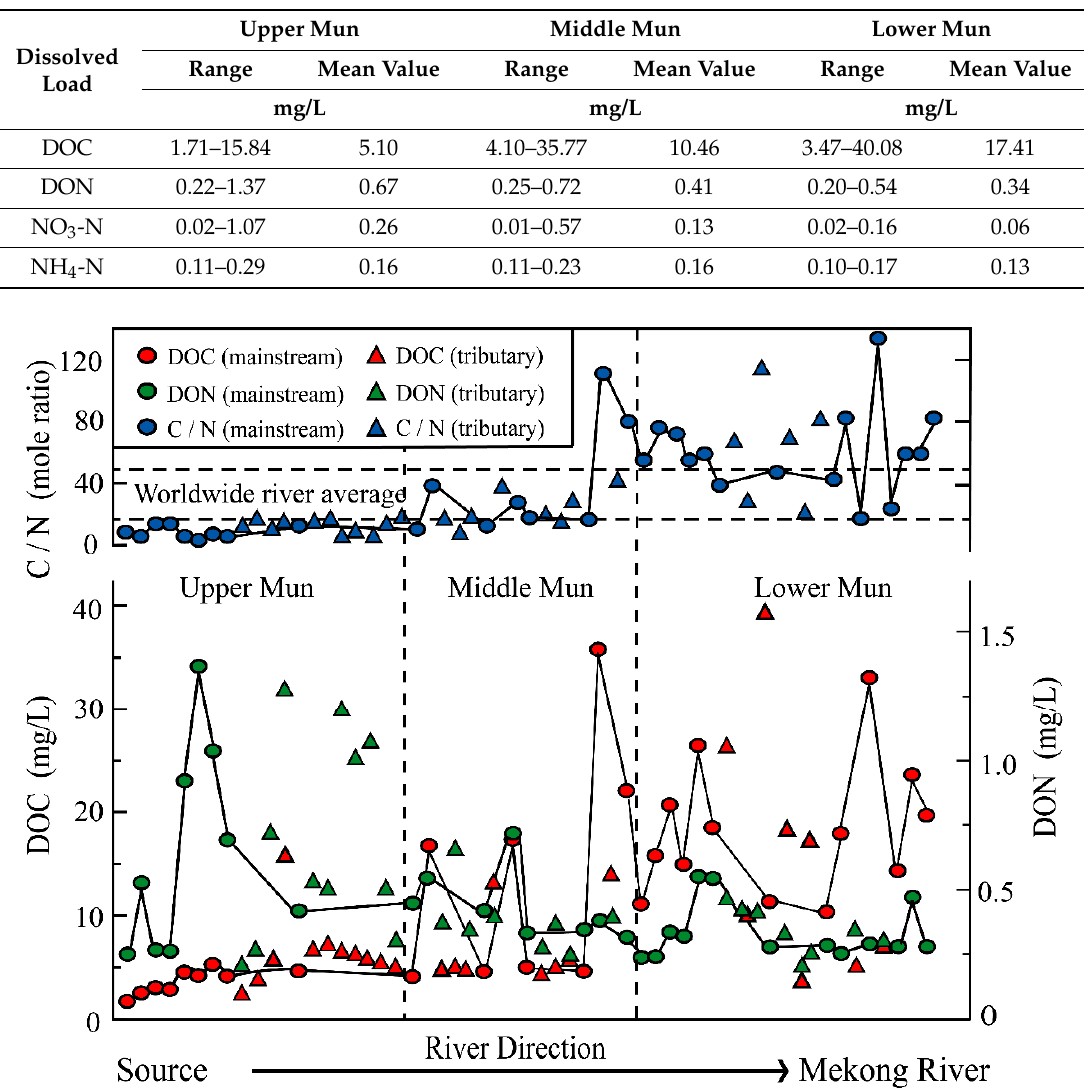
Figure 3. Spatial distributions of DOC, DON, and the DOC/DON mole ratio in the Mun river.